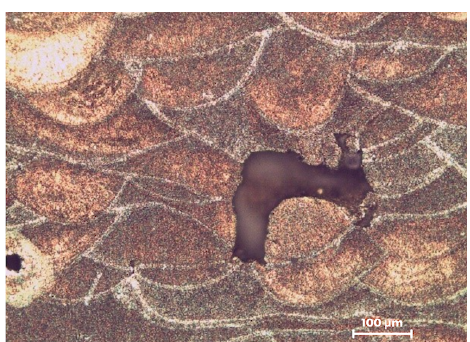
Figure 15. Porosity in a transversal section.